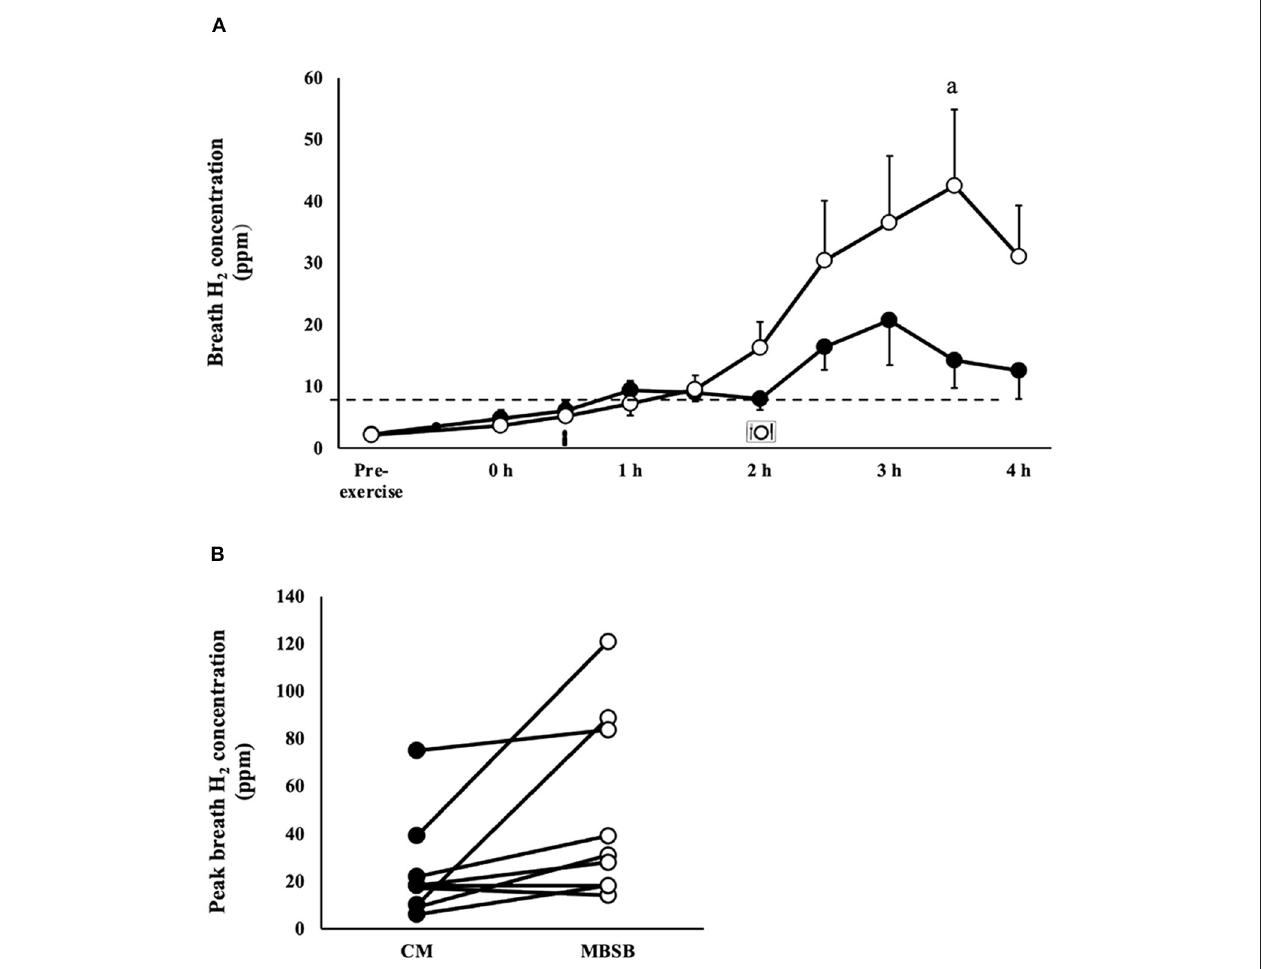
FIGURE 2 | Breath hydrogen response (A) and individual peak breath hydrogen (B) after 2h HIIT exercise in temperate ambient conditions and consumption of a whole food dairy milk (CM: (cid:4) ) and a reconstituted milk based supplement (MBSB: ◦ ) recovery beverage. Mean ± SEM ( n = 9): a P < 0.05 vs. CM.